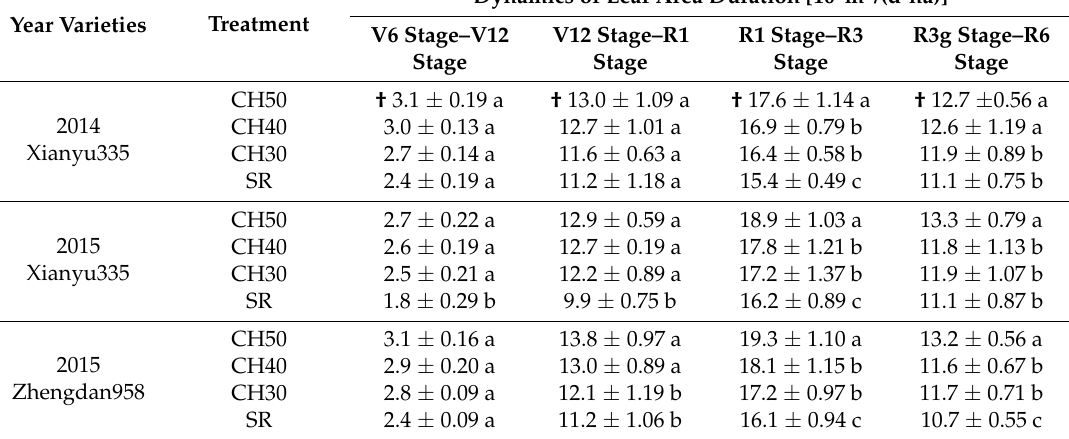
Table 3. Dynamics of leaf area duration under different chiseling depths for two maize varieties grown in 2014 and/or 2015. Values are the average ± 1 standard